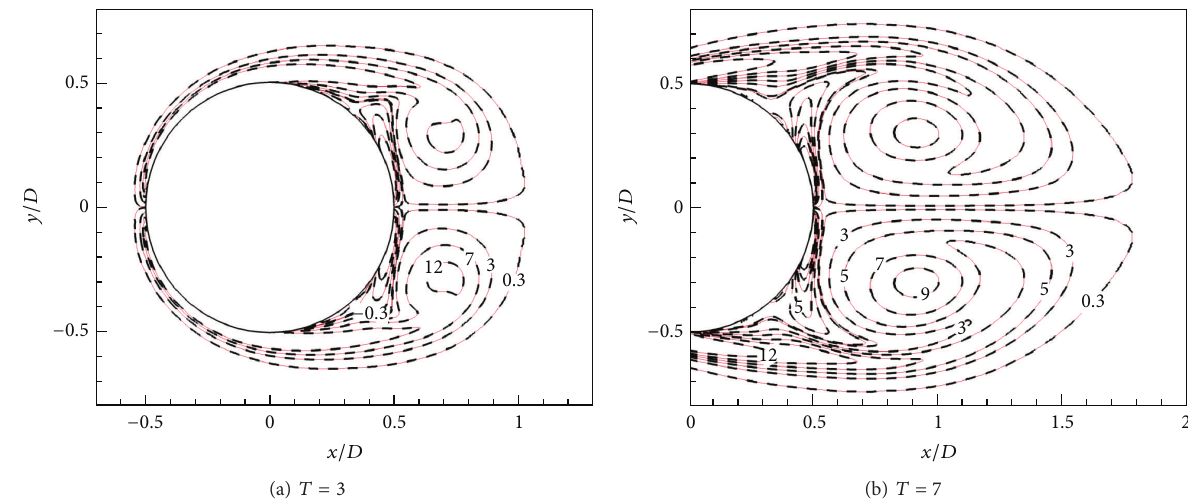
Figure 15: Comparison of vorticity isocontours on different computational domain sizes for Re = 550 : FFT points of 1024 × 1024 ( solid line ) versus 4096 × 4096 ( dashed line